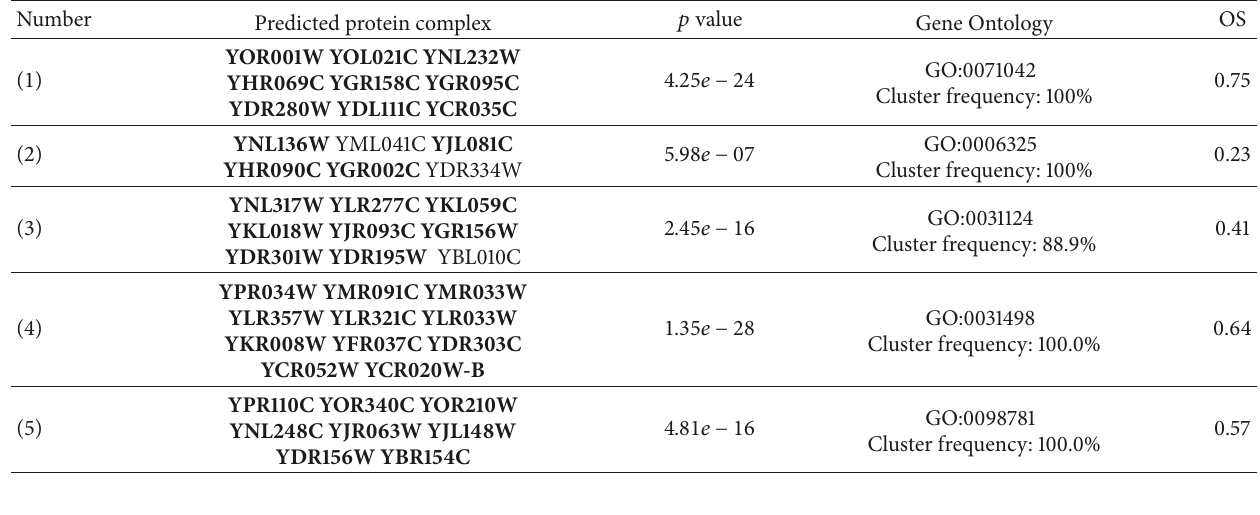
Table 4: Function enrichment analysis of five predicted protein complexes detected form Krogan dataset.